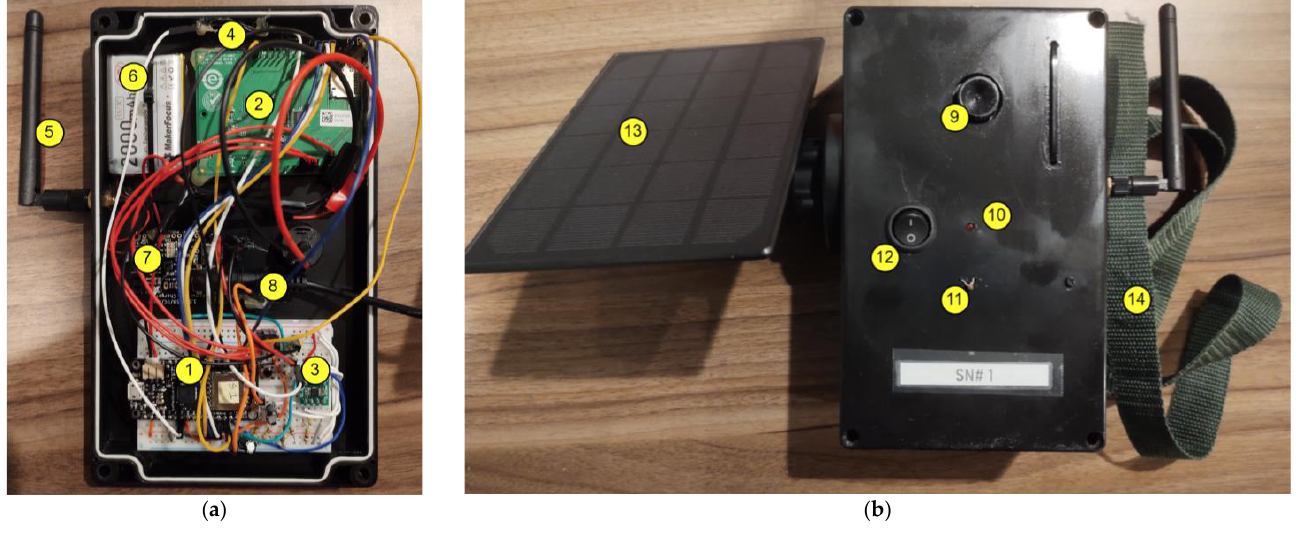
Figure 10. Photograph of the sensor node: ( a ) bottom view of the front cover—(1) LoRa32u4 II development board, (2) CN0537 board containing smoke, temperature, and humidity sensors, (3) sudden rise in temperature (SRT)-detector circuit using op-amp, (4) light sensor, (5) LoRa antenna, (6) battery, (7) charger module, (8) solar panel connector; ( b ) top view of the sensor node—(9) smoke chamber, (10) heartbeat LED, (11) thermistor, (12) power switch, (13) solar panel, (14) belt for hanging.